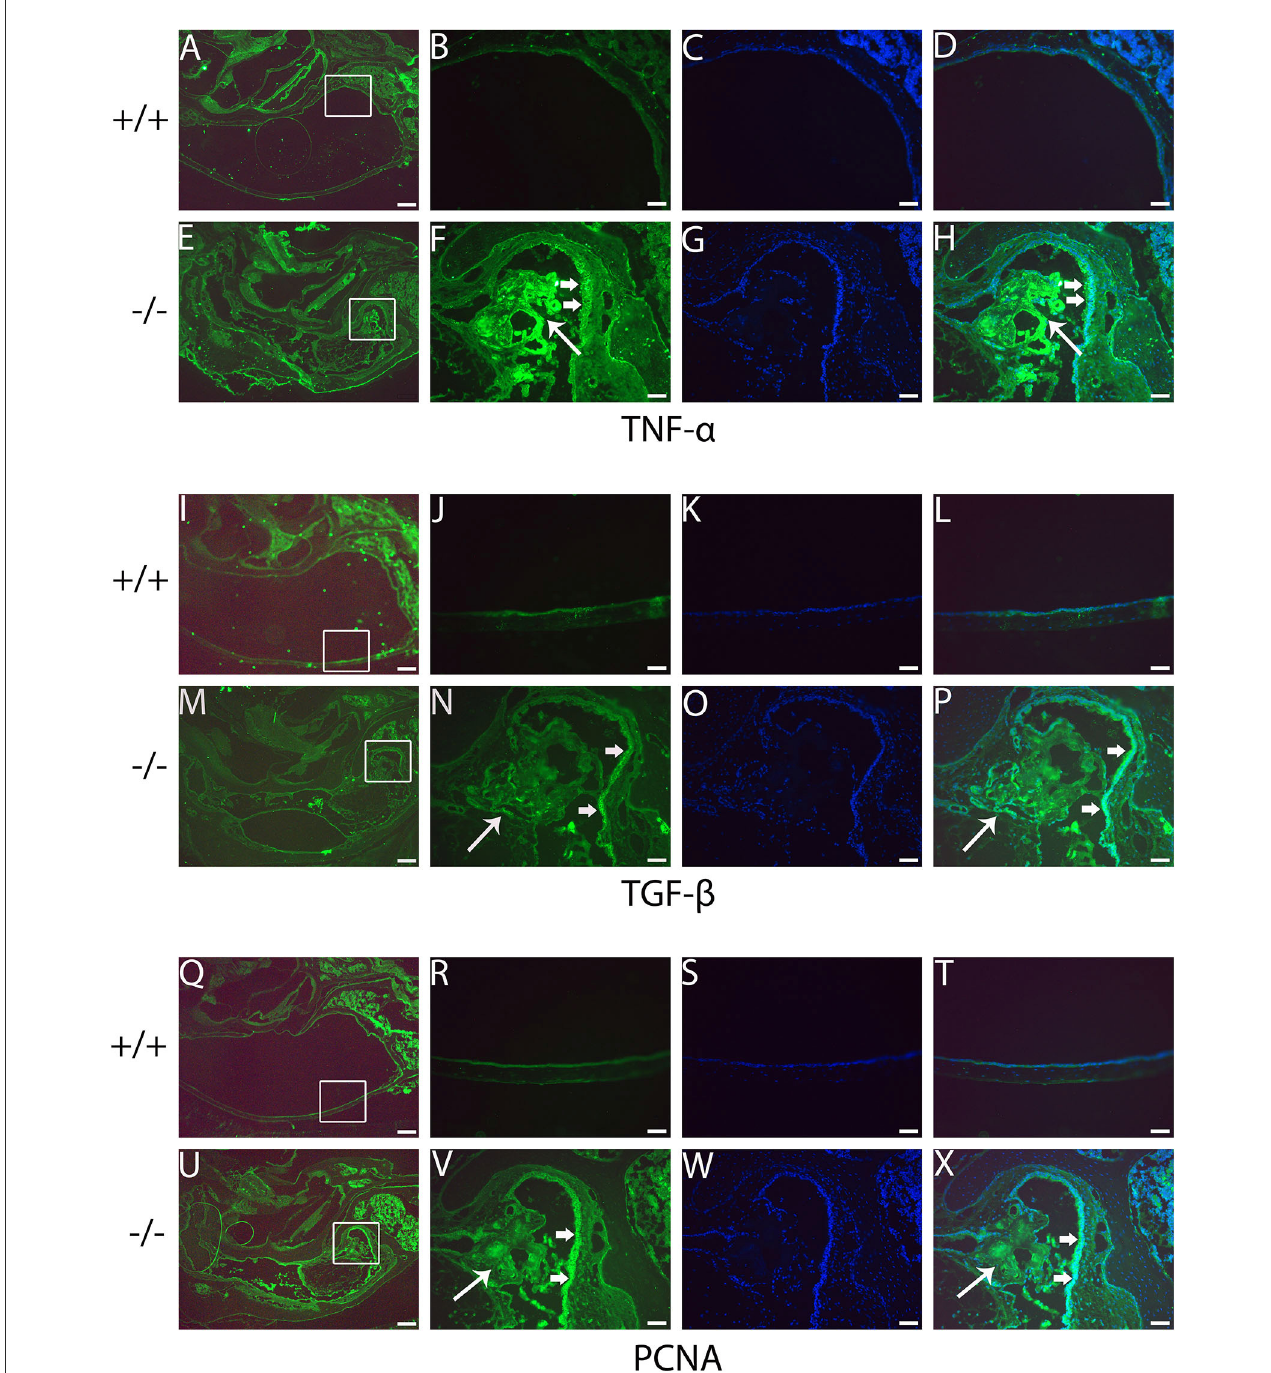
FIGURE9 Immunofluorescent detection of pro-inflammatory proteins such as tumor necrosis factor-alpha (TNF- α ), transforming growth factor-beta (TGF- β ), and proliferating cell nuclear antigen (PCNA) in mutant mice. Representative images from 6-month-old wild type ( + / + ) and mutant (-/-) mice ( n = 3 for each group) stained with anti-TNF- α , anti-TGF- β , and anti-PCNA antibody and revealed with Alexa Fluor 488 (green). (A, E, I, M, Q, U) show gross morphology of the middle ear. (B, F, J, N, R, V) represent the enlarged image corresponding to the rectangular region in the left. Images (C, G, K, O, S, W) counterstained with 4 ′ ,6-diamidino-2-phenylindole (DAPI) reveal the nuclei in these tissues. (D, H, L, P, T, X) on the right are merged with the images (B, F, J, N, R, V) and the images were counterstained with DAPI. The intensities of TNF- α , TGF- β , and PCNA are all stronger in the mutant mice than in control mice (F, N, V, H, P, X) . The expression of TNF- α in the inflammatory tissue of the middle ear cavity (short arrow) is higher than that in the mucosa of the middle ear cavity (long arrow) (F, H) . The expression of TGF- β and PCNA is higher in the mucosa of the middle ear cavity (short arrow) compared to the inflammatory tissue of the middle ear cavity (long arrow) (N, V, P, X) . Scale bars: 200 µ m (A, E, I, M, Q, U) ; 50 µ m (B–H, J–L, N–P, R–T, V–X)